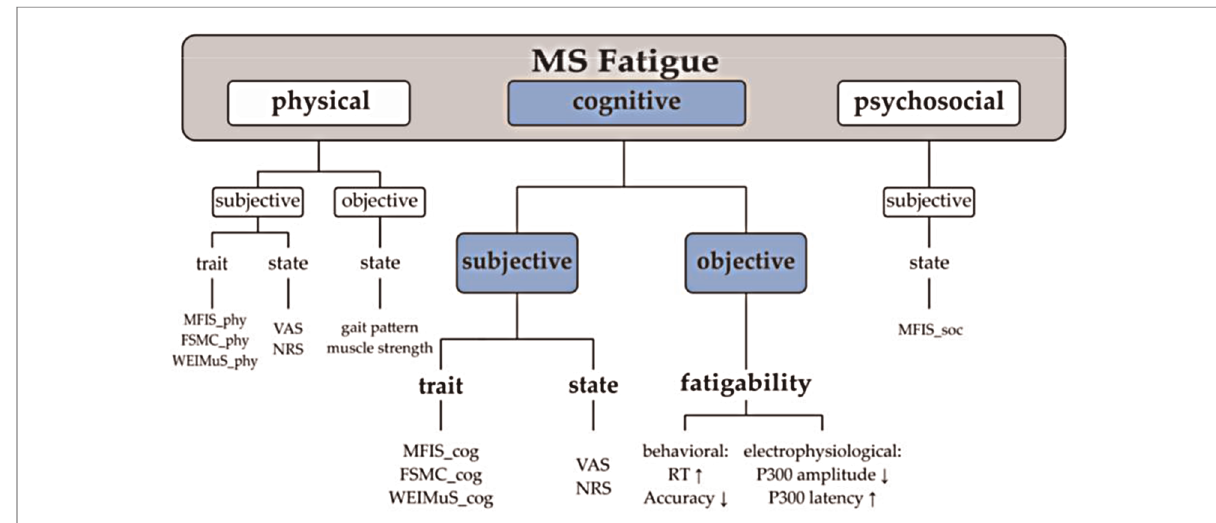
FIGURE 1 Uni fi ed fatigue taxonomy. Fatigue classi fi cation. MRS, Modi fi ed Fatigue Impact Scale; MS, multiple sclerosis; FSMC, Fatigue Scale for Motoric and Cognitive Functions; WEIMuS, WuerzburiFatigue Inventory for Multiple Sclerosis; VAS, Visual Analogue Scale; NRS, Numerical Rating Scale; RT, reaction time